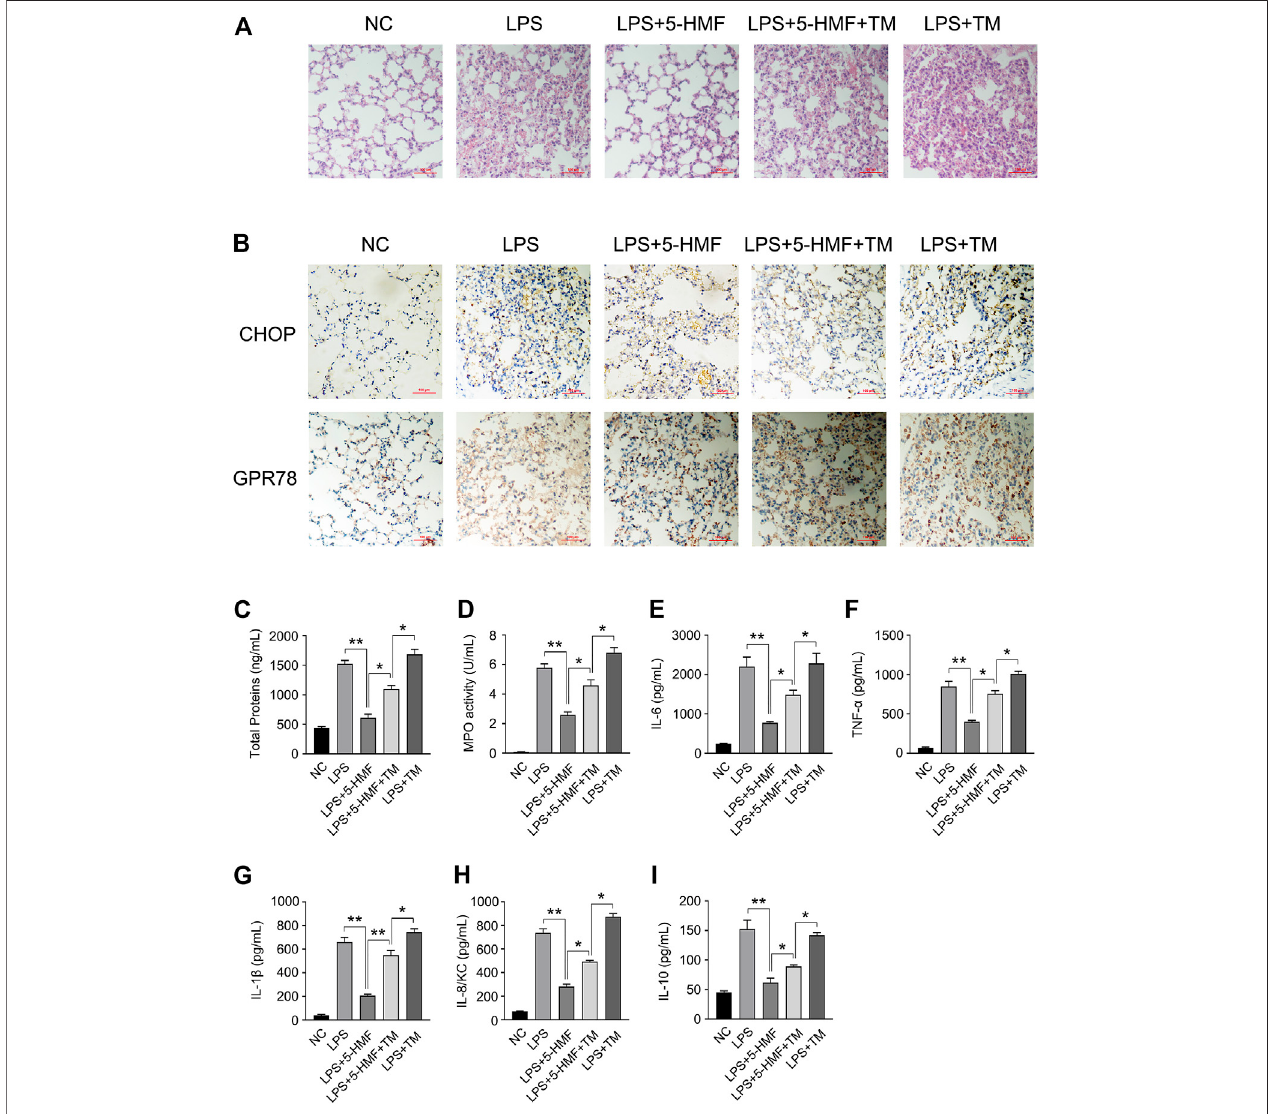
FIGURE 7 | Inhibition of ER stress by 5-HMF mediates amelioration of LPS-induced acute lung injury. C57BL/6J mice (5 mice/group) pretreated with PBS or 5- HMF(12 mg/kg,i.p.)and/ortunicamycin(TM,0.2 mg/kg,i.p.)werechallenged withLPS(1 mg/kg,i.p.). (A) RepresentativeimagesofH&E-stainedlungtissuesections from the indicated groups ( × 200), Scale bar, 100 μ m. (B) Representative IHC images showing in-situ expression of CHOP and GPR78 in lung tissues of mice ( × 200), Scalebar,10 μ m. (C) ProteincontentinBALF. (D) MPOactivity oflungtissues. (E – I) IL-6 (E) ,TNF- α (F),IL-1 β (G) ,IL-8/KC (H) and IL-10 (I) levelsinsera.Allresults are expressed as the mean ± SD: * and ** indicate p < 0.05 and p < 0.01 respectively by Student ’ s t-test.